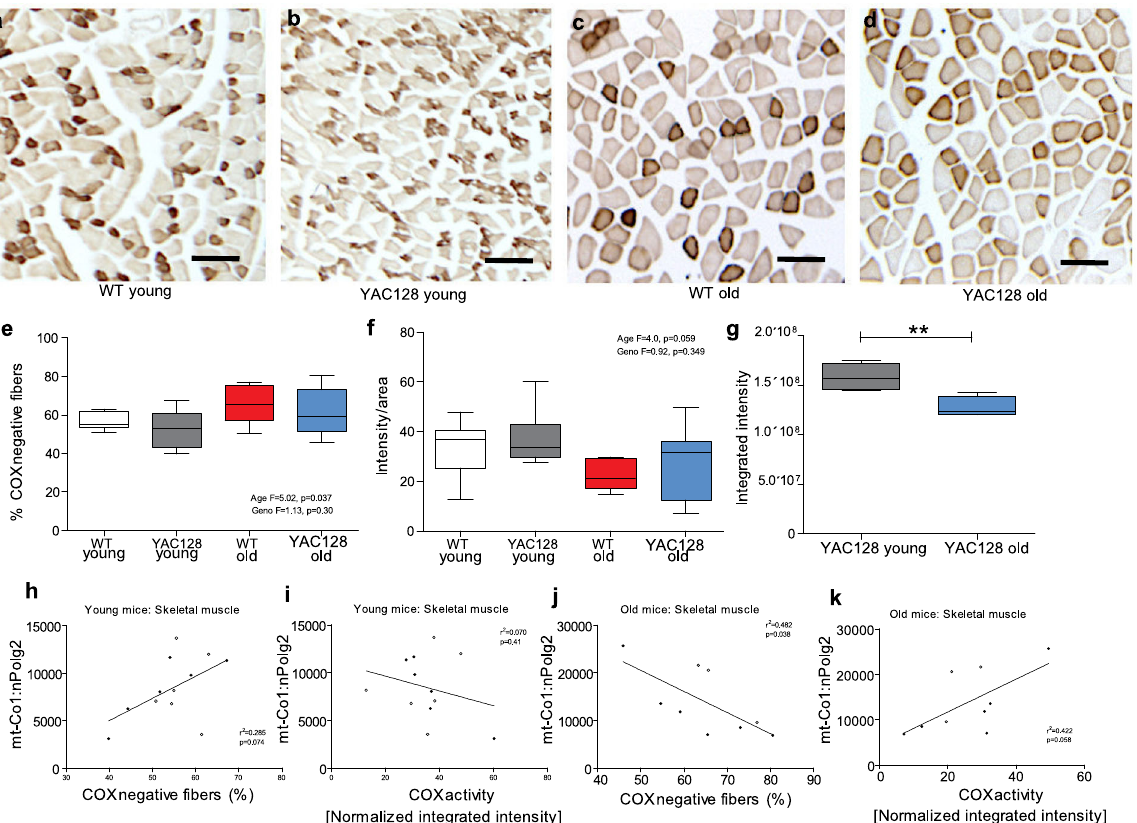
Fig. 4 Age-related decrease in cytochrome c oxidase (COX) de fi ciency in striatum and skeletal muscle. Cytochrome c oxidase staining was performed on frozen sections of quadriceps from a young WT (1 month), b young YAC128 (1 month), c old WT (21 months) and d old YAC128 (21 months) (representative images). Scale bar = 250 μ m. e The numbers of COX-negative fi bers increased in an age-dependent manner. f Semi-quantitative assessment of staining intensity showed a borderline signi fi cant age-related decrease in aged mice. g In striatal tissue, the COX-staining intensity was decreased in aged YAC128 ( n = 5) compared to young YAC128 mice ( n = 4). h Correlation between the mtDNAcn and the number of COX-negative muscle fi bers in young WT ( n = 6) and YAC128 mice ( n = 6). i Correlation between the mtDNAcn and COX- staining intensity in young WT ( n = 6) and YAC128 mice ( n = 6). j Correlation between the mtDNAcn and the number of COX-negative muscle fi bers in old WT ( n = 3) and YAC128 mice ( n = 6). k Correlation between the mtDNAcn and COX-staining intensity in old WT ( n = 3) and YAC128 mice ( n = 6). Young mice = 1 month; old mice = 18 – 22 months of age. Open circles represent WT; closed circles represent YAC128. Two-way ANOVA with Tukey ’ s multiple comparison test, unpaired two-sided t test and simple linear regression were used for statistical analysis. ** p < 0.01.